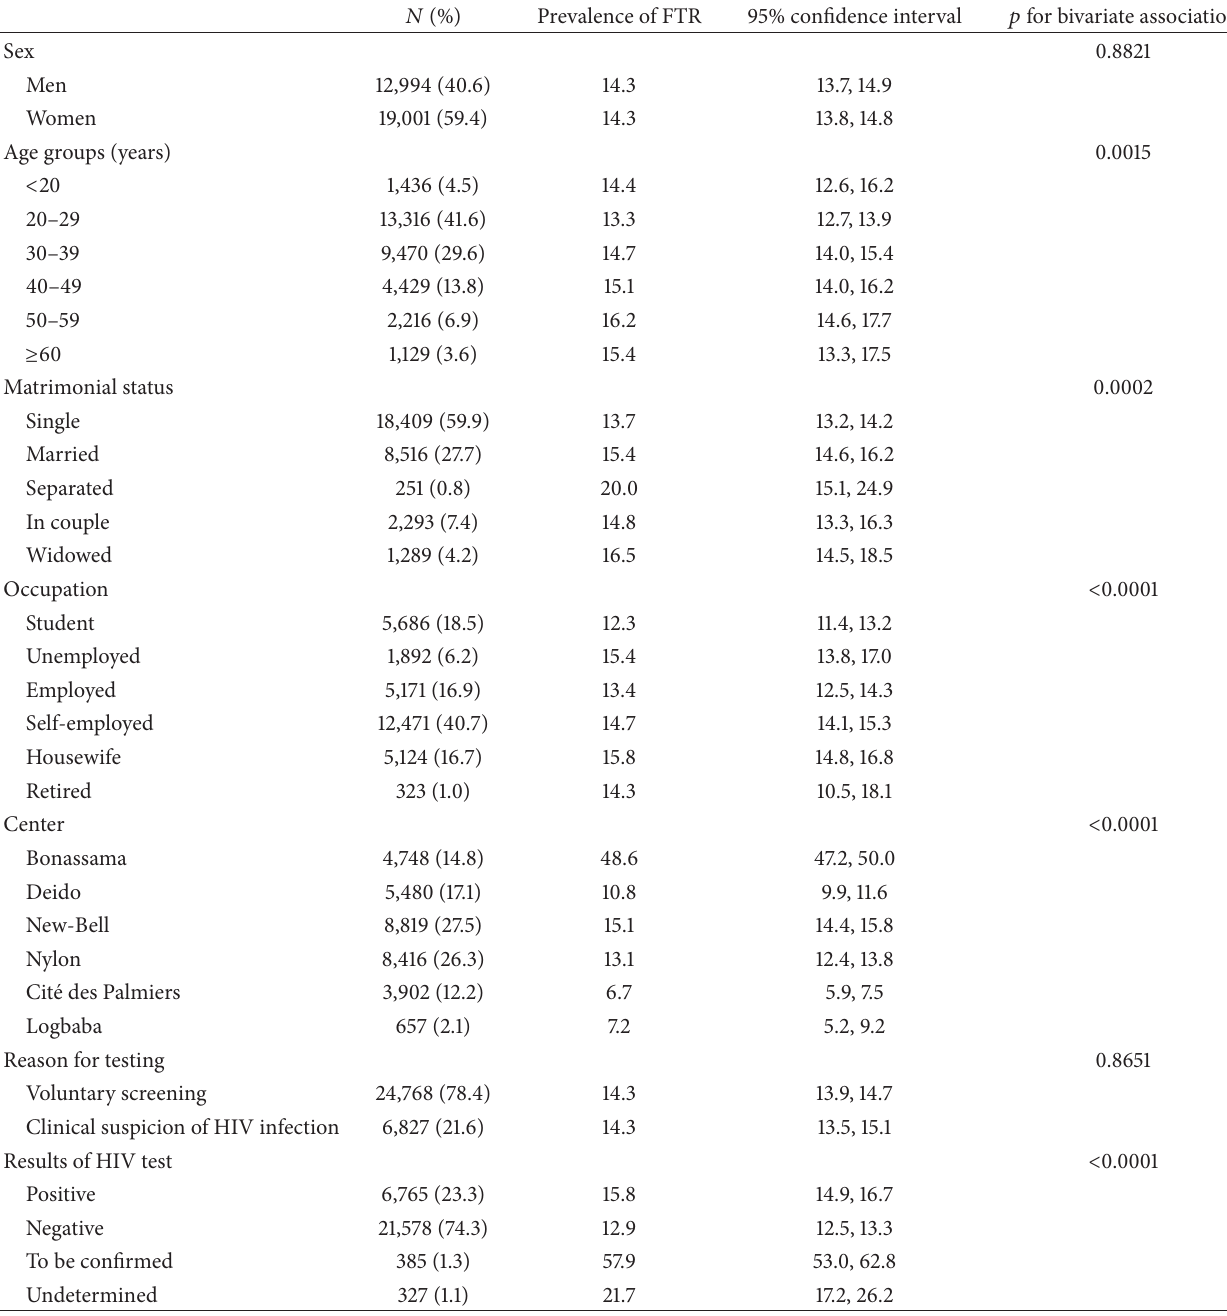
Table 2: Prevalence of failure to return (FTR) by client